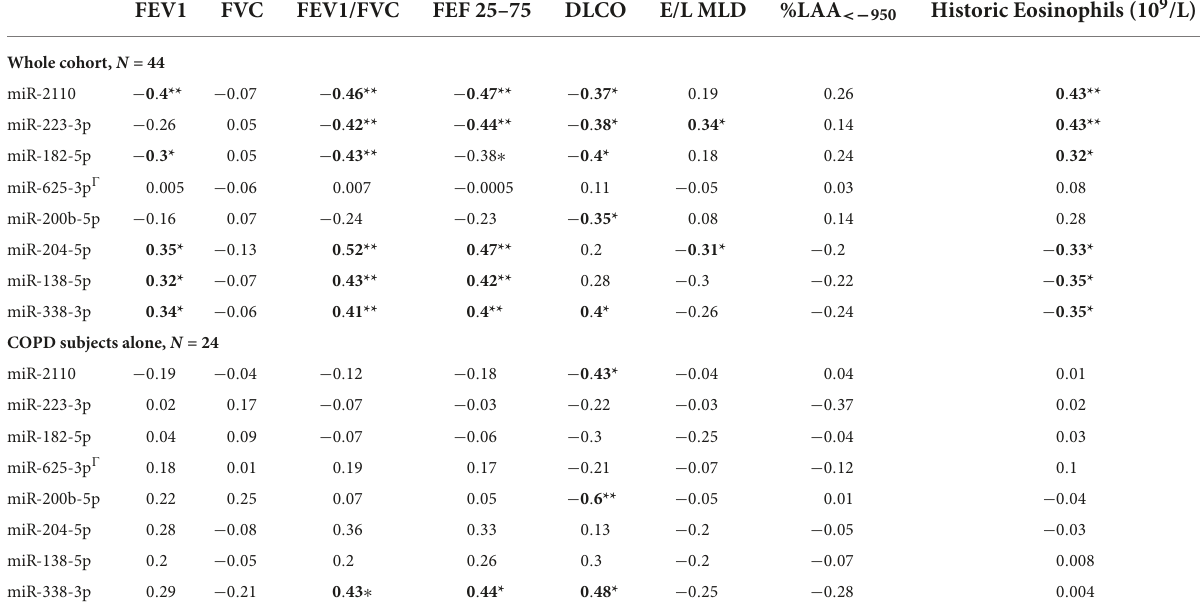
TABLE 2 Correlations of lung-derived extracellular vesicle (EV) microRNA (miRNA) expression with chronic obstructive pulmonary disease (COPD) phenotypic disease